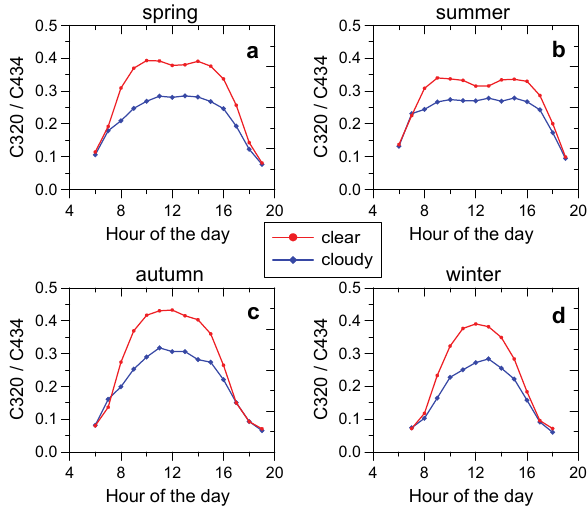
Fig. 13. Diurnal variations of the C320/C434 ratio under clear and cloudy conditions, averaged for different seasons from August 2008 to September 2011.